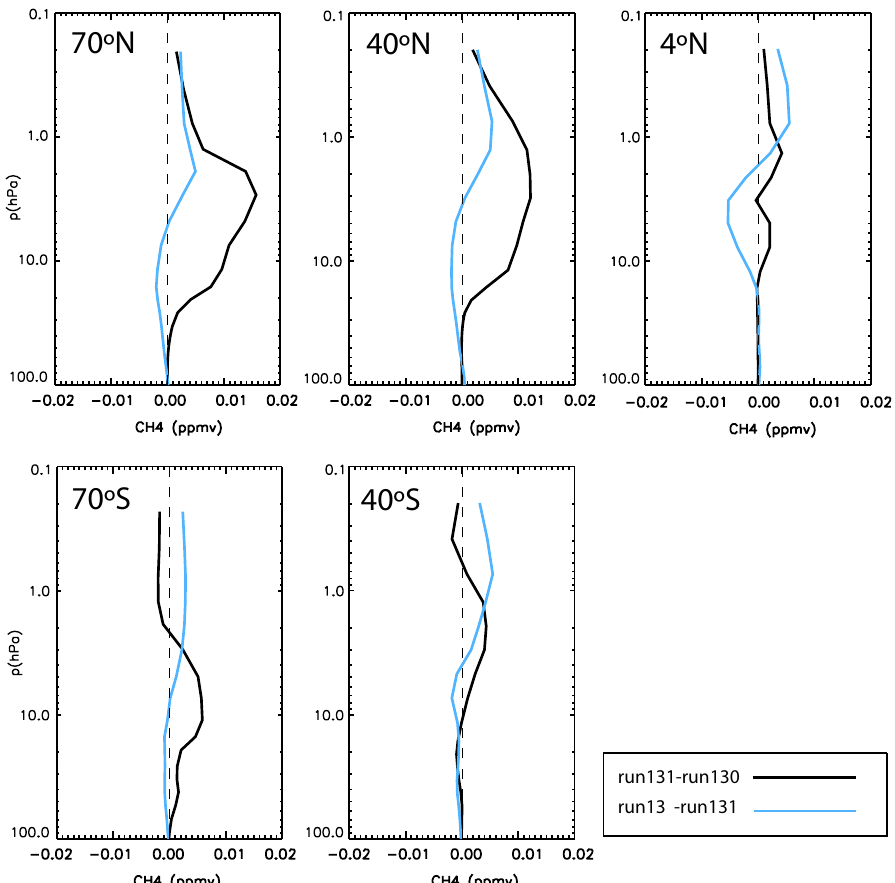
Fig. 7. Annual average (year 2000) of the profiles for CH 4 differences (ppmv) between run131 and run130 (black line) and between run13 and run131 (blue line). Run13 uses the full parameterisation as in Eq. (12), run130 uses only the first term (c 0 in Eq. (12)) and run131 uses only the c 0 and c 1 terms of the scheme. All runs are driven by ERA-40